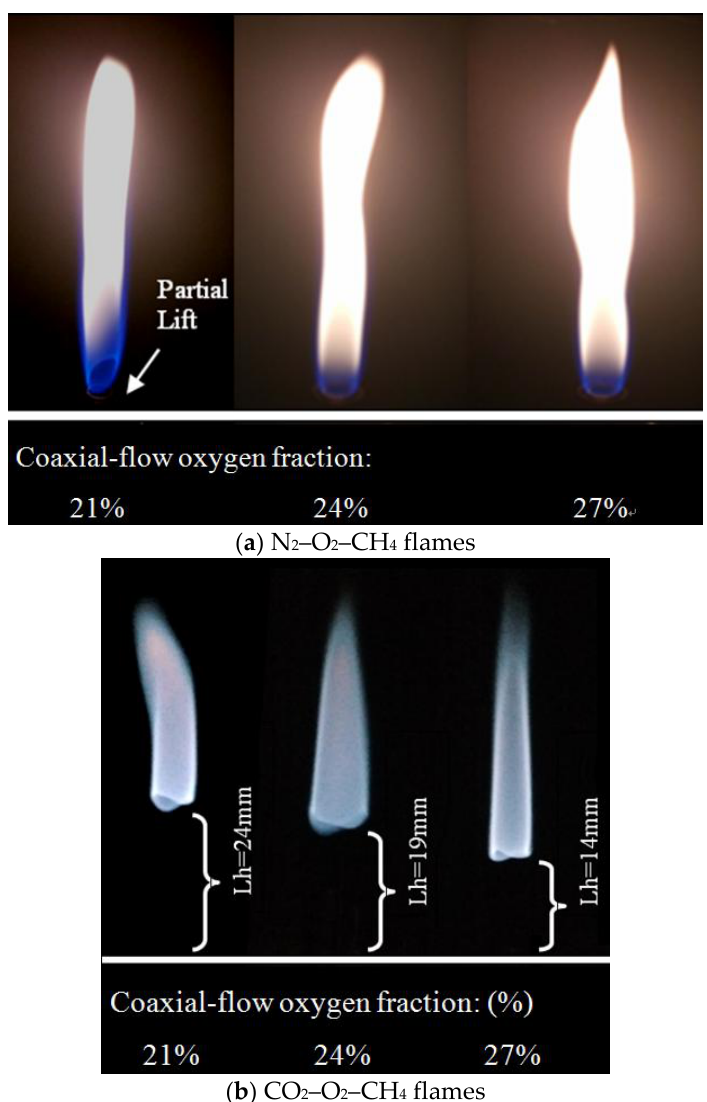
Figure 3. Flame photos against increasing oxygen fraction.